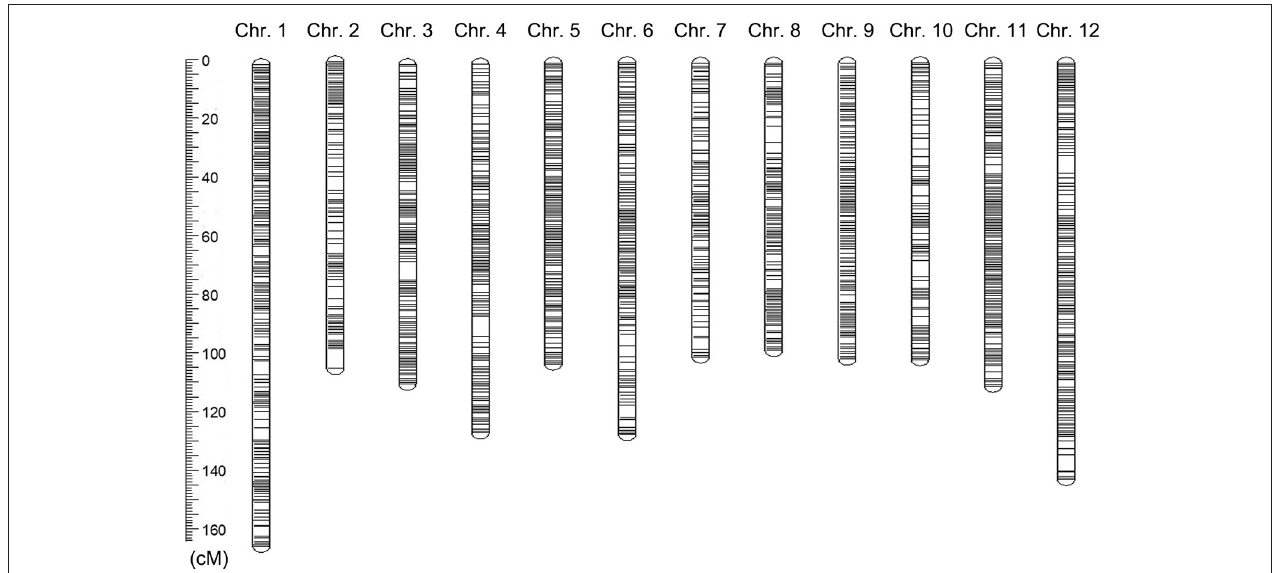
FIGURE 3 | A graphic view of the distribution of markers on chromosomes in eggplant. The rounded rectangles represented the chromosomes in eggplant. The location and thickness of the black lines on the rounded rectangles indicating the location and distribution density of Bin markers on the chromosomes.